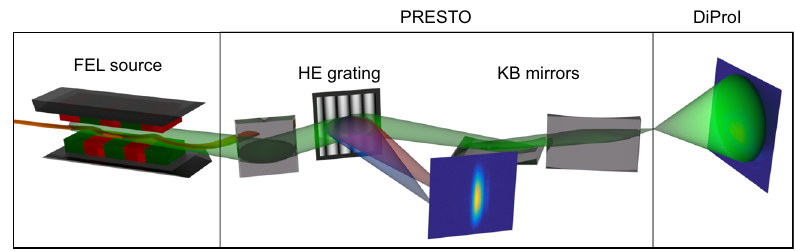
Fig. 1 Schematic layout of the experiment. Radiation generated in the undulators is focused by Kirkpatrick – Baez mirrors and the detector is installed out of focus to observe the direct beam. Radiation from each pulse is partially diffracted by a grating to the spectrometer detector to observe on-line pulse